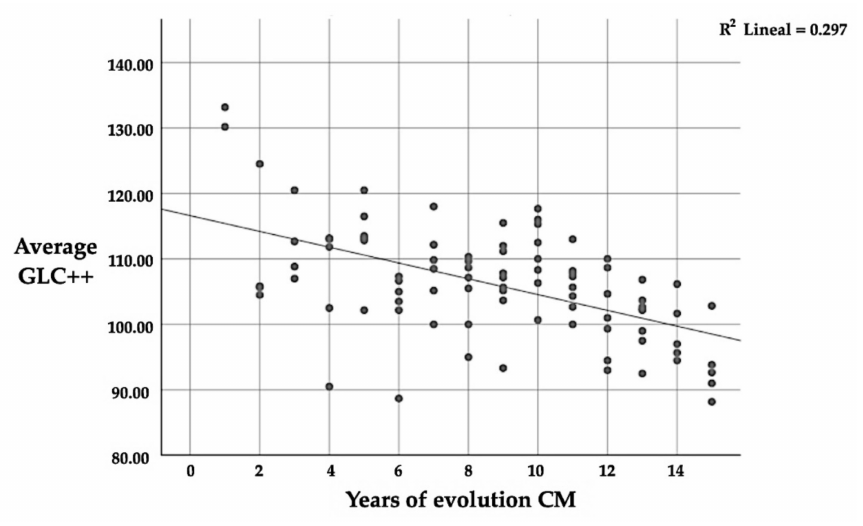
Figure 5. Correlation between GCL++ and the number of years since CM